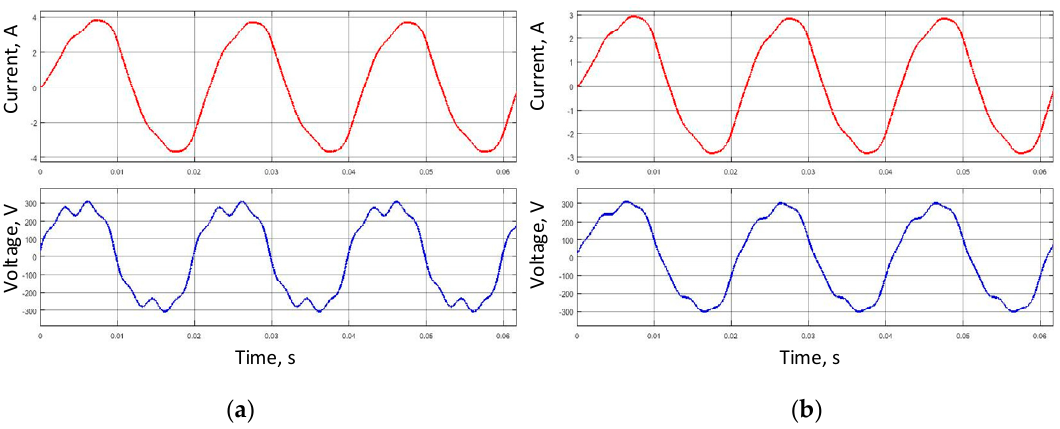
Figure 2. Modeling a circuit on a classic transformer: ( a ) the current and voltage on the primary winding of a classical transformer; and ( b ) the current and voltage on the load for a classical transformer.